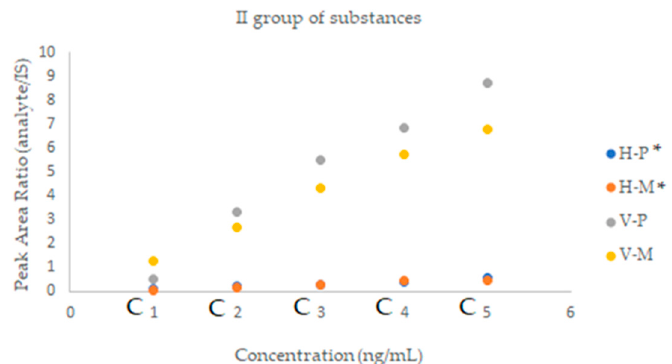
Figure 4. A graphical representation of the matrix effect between two parallel calibration curves for the I group substances, prepared without and with the matrix. P—samples without the matrix, M— samples with the matrix.